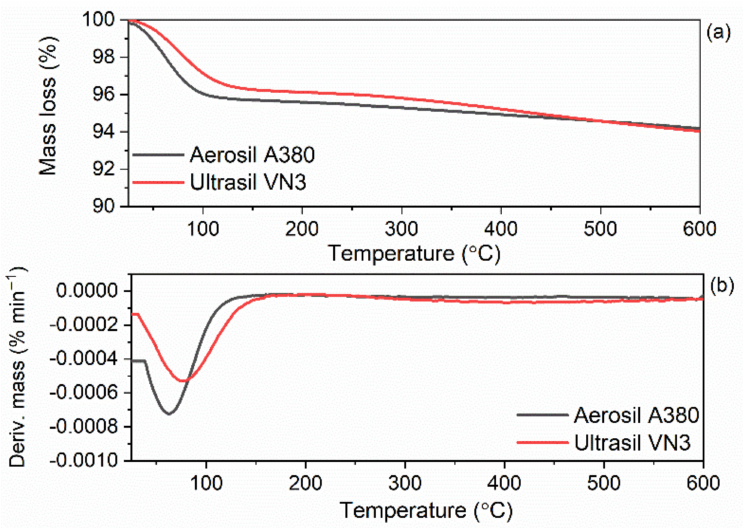
Figure 2. Thermogravimetric (TG) and derivative thermogravimetric (DTG) curves of silica A380 and VN3: ( a ) TG curves; ( b ) DTG